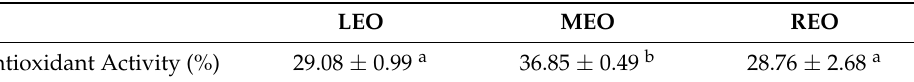
Table 2. Antioxidant activity of the analysed